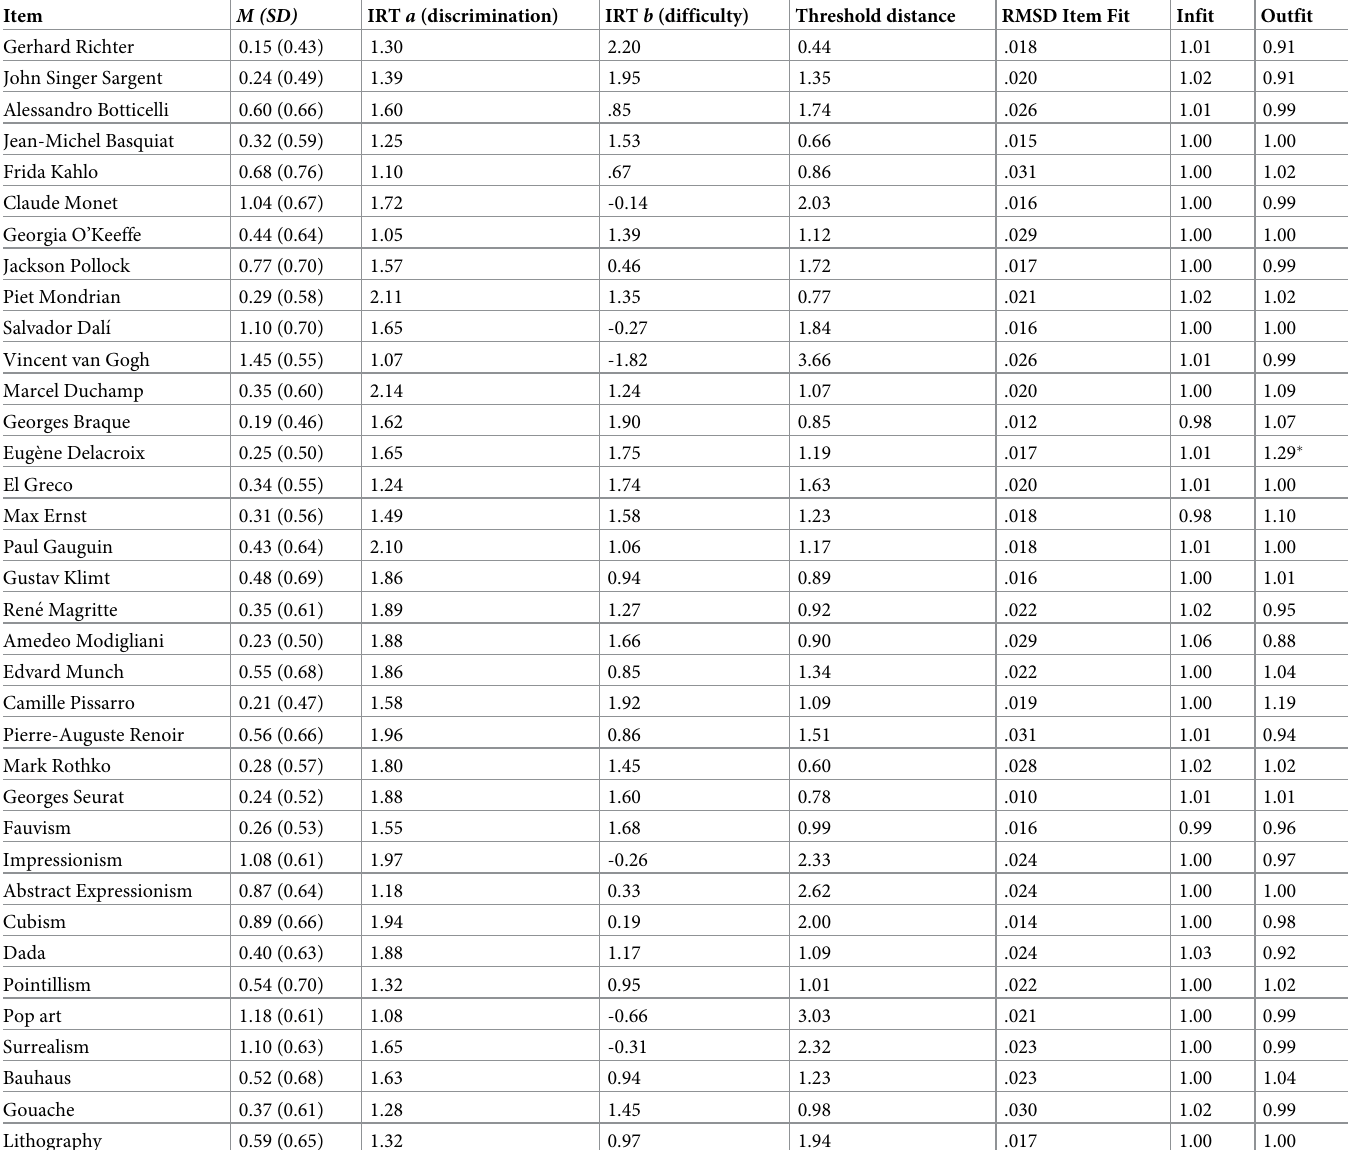
Table 1. Revised Aesthetic Fluency Scale: Items and